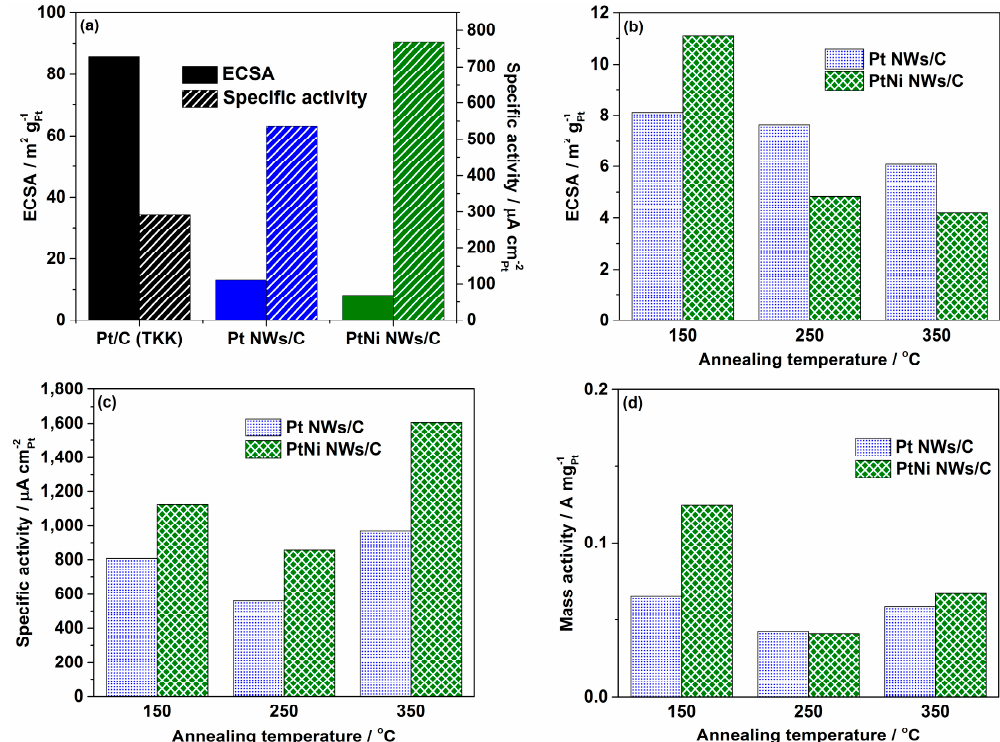
Figure 4. ( a ) Electrochemically active surface areas (ECSA), specific, and mass activity of Pt/C (TKK), Pt NWs/C, and PtNi NWs/C; ( b ) ECSA; ( c ) Specific activity and ( d ) Mass activity of annealed samples of Pt NWs/C, and PtNi NWs/C determined from the thin-film rotating disk electrode measurements (TFRDE) measurement.